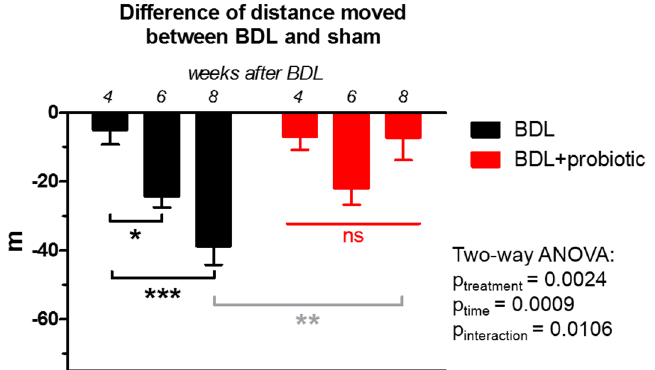
Figure 4. Performance in open field test. In black, difference in distance moved in meters (m) during the open field test between BDL rats and their shams at corresponding weeks. In red, difference between BDL + probiotic rats and their shams (sham + probiotic). There was no significant change between any weeks in BDL + probiotic group. Significance (one-way ANOVA with Bonferroni corrections) is given intra-group (black, red) or between the two groups at week 8